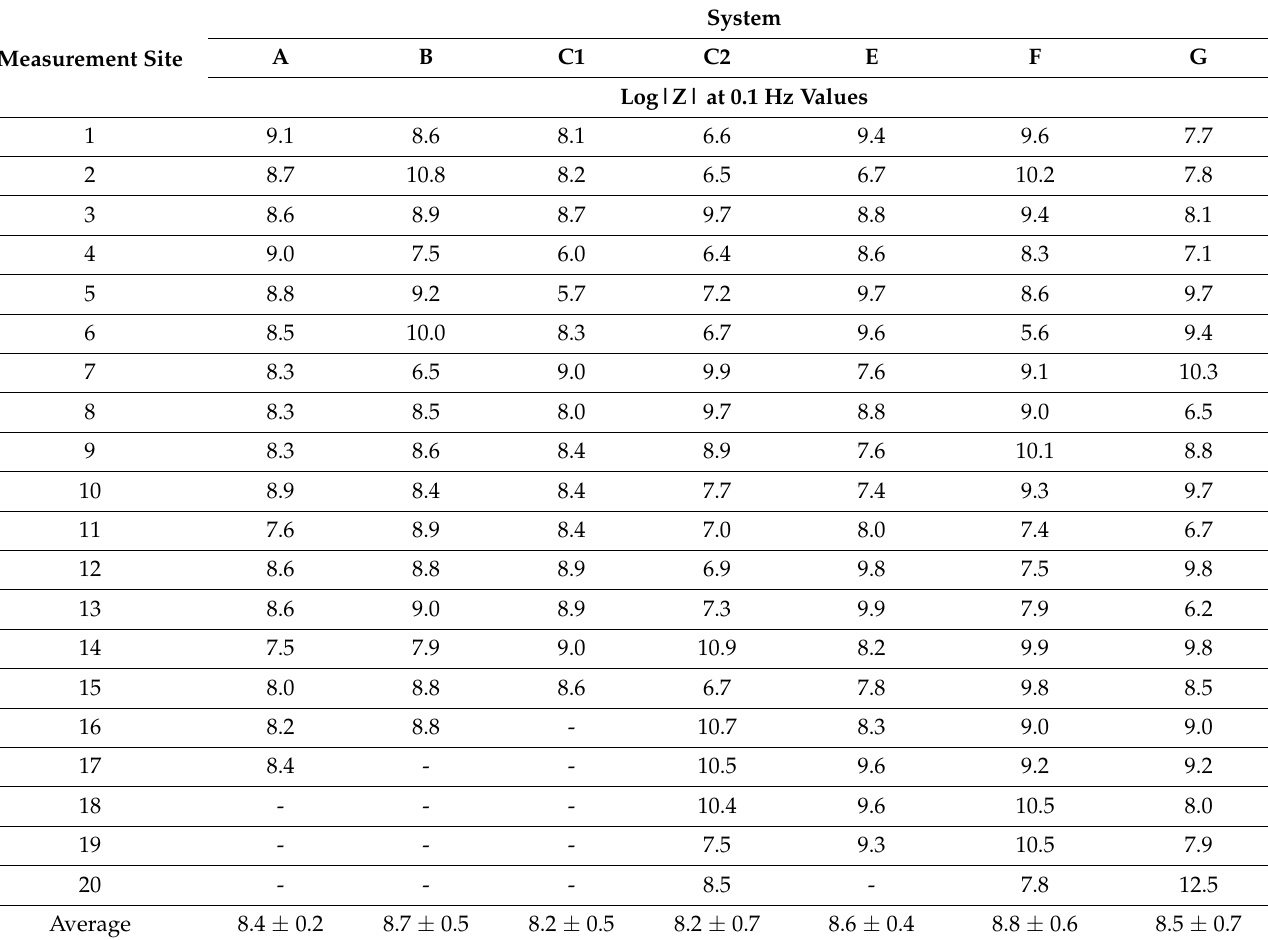
Table 5. Log|Z| at 0.1 Hz values at individual measurement sites and their average values.